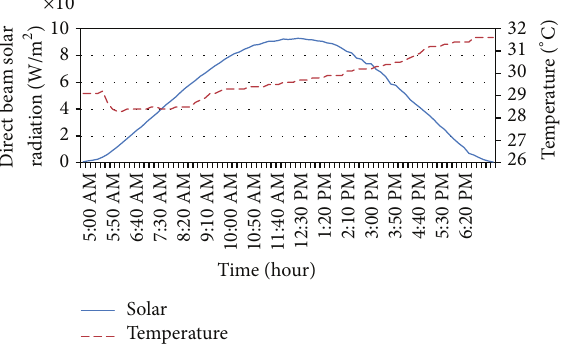
Figure 10: Direct beam solar radiation and ambient temperature for Helwan city, Egypt.